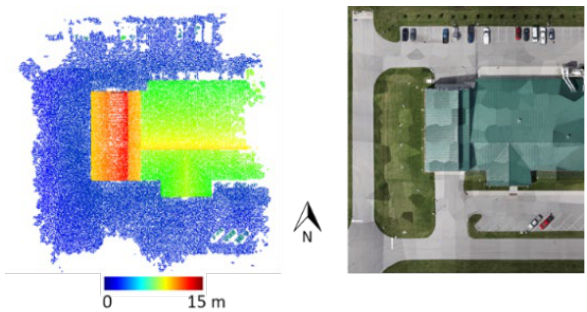
Figure 5. Generated dense point cloud (colored by height) with 80,000 points and corresponding orthophoto for A-1 dataset.